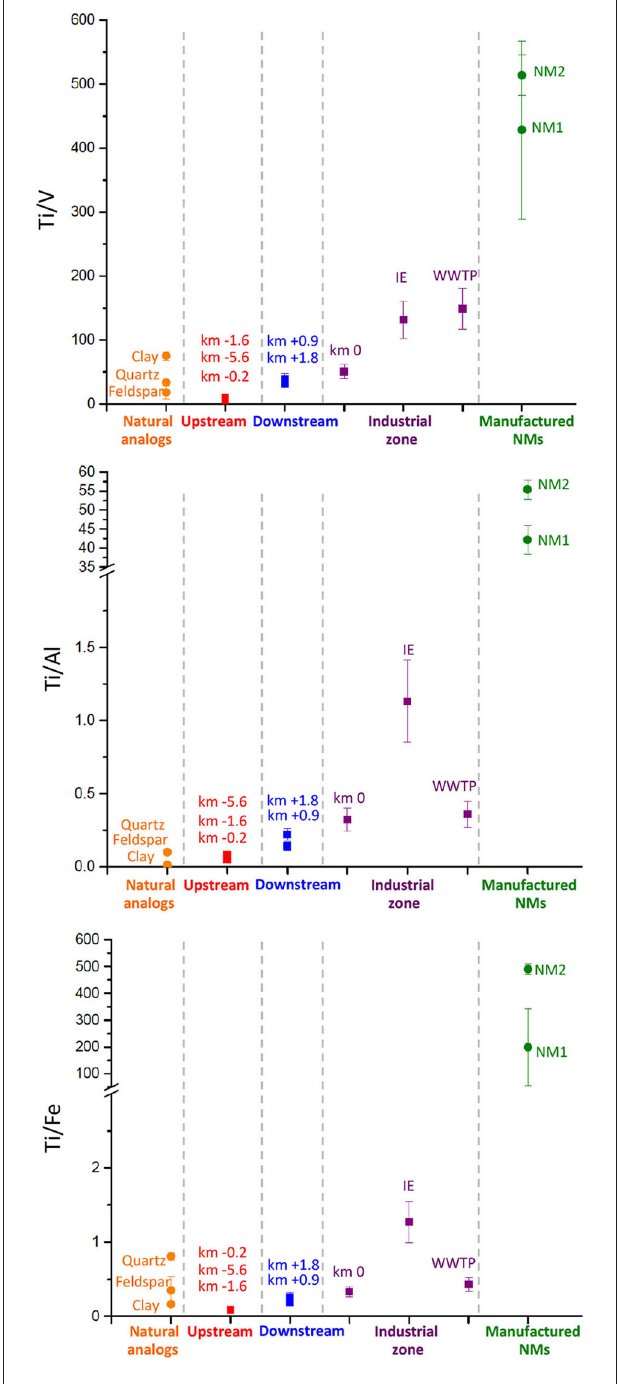
FIGURE 5 | Elemental analysis of surface waters from October 2017: Ratios of Ti/X (X = V, Al, and Fe) showing anthropogenic inputs. IE, Industrial Effluent. Error bars represent replicate sample digestions of the same sample ( n =